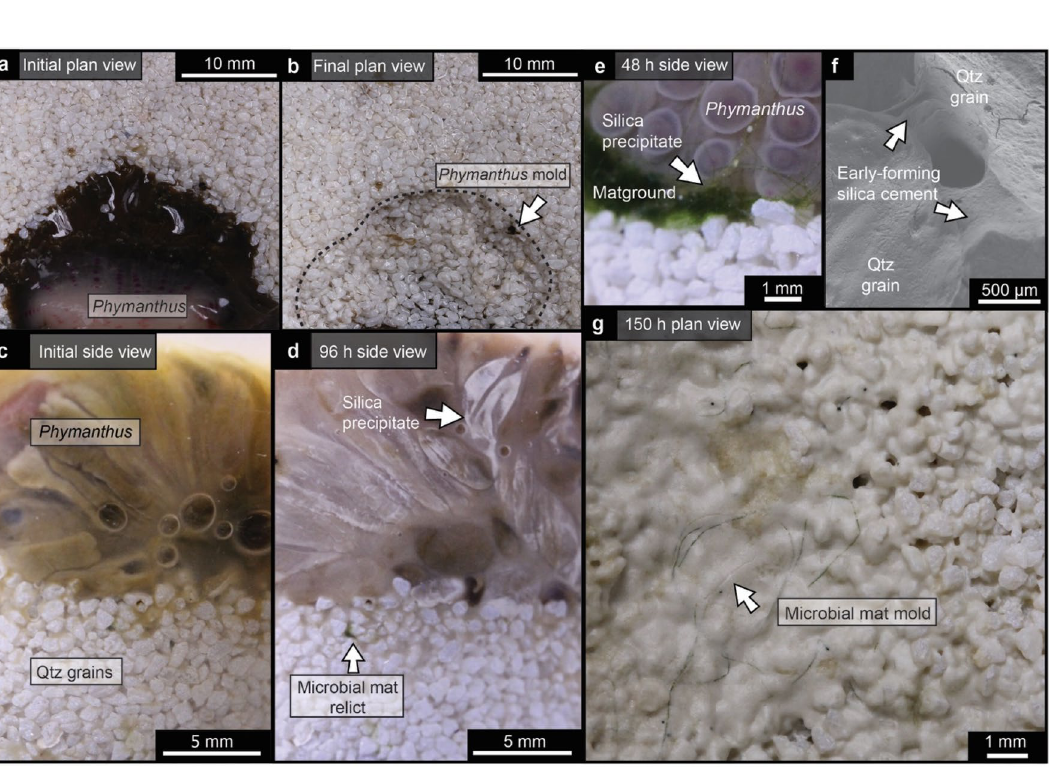
Figure 2. Ediacara-style experiments through time. ( a , b ) Plan-view photographs of a representative fossilization experiment conducted with Phymanthus , Anabaena, Fischerella, Spirogyra , and Vaucheria , taken at the start (0 h; a ) and end (150 h; b ) of the experiment (experiment 11, Table 1). ( c – e ) Cross-section photographs taken at distinct intervals throughout experiment 11, showing Phymanthus shortly following the start of the experiment (0 h; c ); silica precipitates on the exterior of Phymanthus tentacles after 96 h ( d ); and silica precipitates associated with both Phymanthus and biofilms after 48 h ( e ). ( f ) SEM secondary electron image showing the presence of early-forming silica cements between sand grains after 72 h in experiment 11. ( g ) Plan view of an experiment with biofilms (experiment 10, Table 1) that, following degradation of organic matter, was characterized by molds of microbial filaments, associated with extensive (including inter-granular) silica